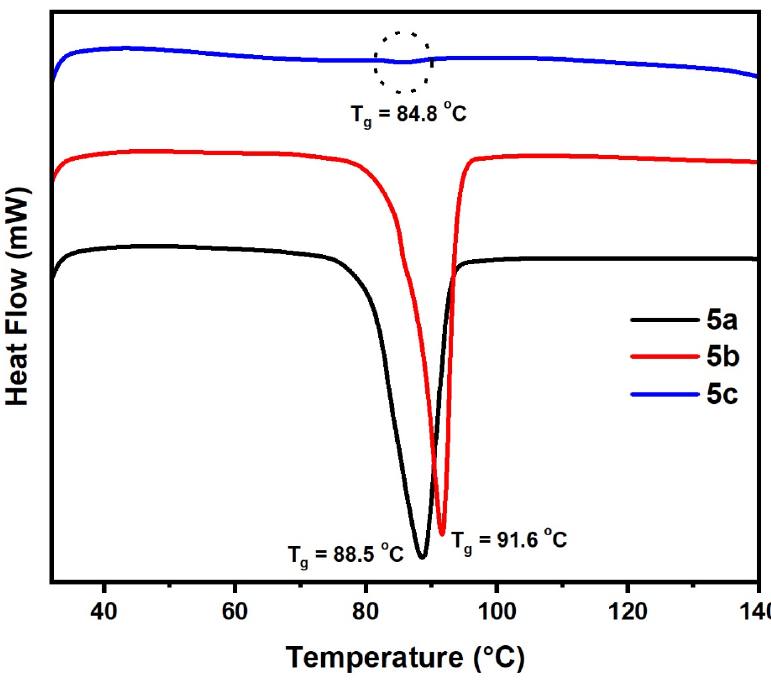
Figure 8. DSC analysis of samples ( 5a – c ).